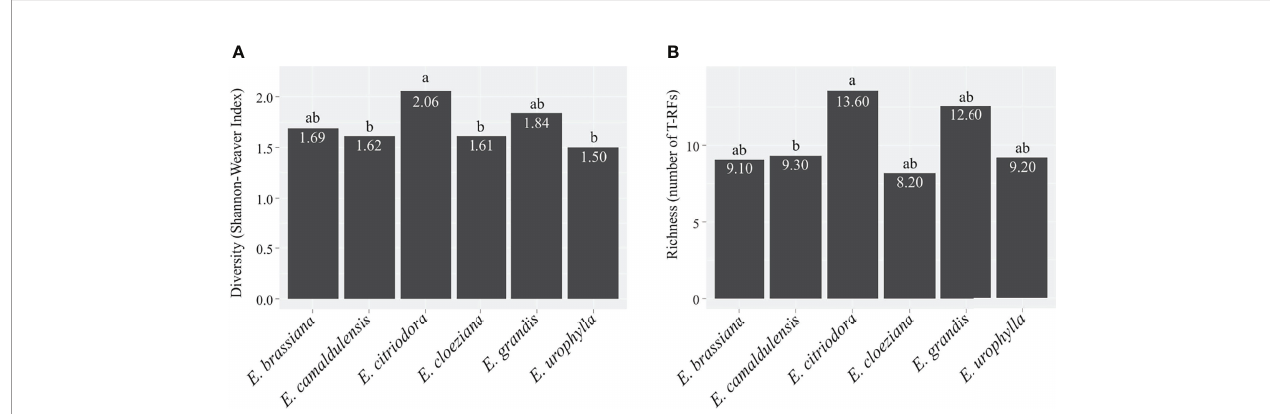
FIGURE 3 | Diversity (A) and Richness (B) of the soil-fungal community structure in plots with different Eucalyptus species based on terminal restriction fragments (T-RFs). Indexes considering the matrix of the peak area obtained by terminal restriction fragment length polymorphism of the soil fungal community structure in different Eucalyptus species plantations. Numbers within the bars denote the mean value of each Eucalyptus species and lowercase letters represent the comparison of different Eucalyptus species by the Kruskal – Wallis test by ranks (p ≤